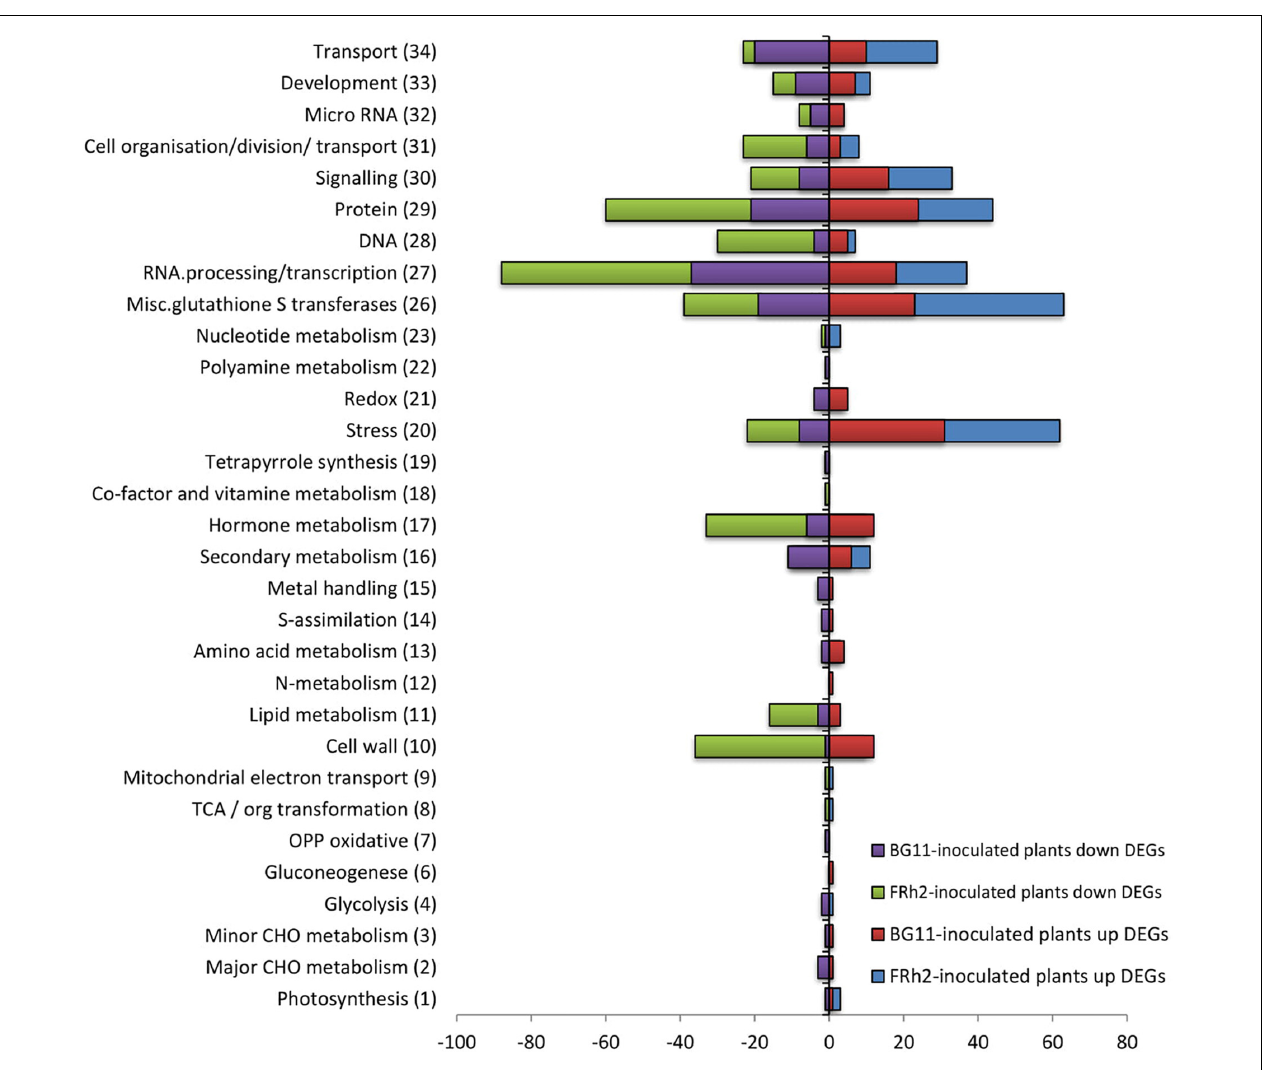
FIGURE 4 | Numbers of differentially expressed genes (DEGs) assigned into MapMan bins (bin number in brackets) from FRh2- and BG11-inoculated plants. Downregulated DEGs are negative. Unassigned DEGs were 142, –225, and 61, –98 for FRh2- and BG11-inoculated plants, respectively. OPP, oxidative pentose phosphate; TCA/org transformation, tricarboxylic acid cycle/organic acid